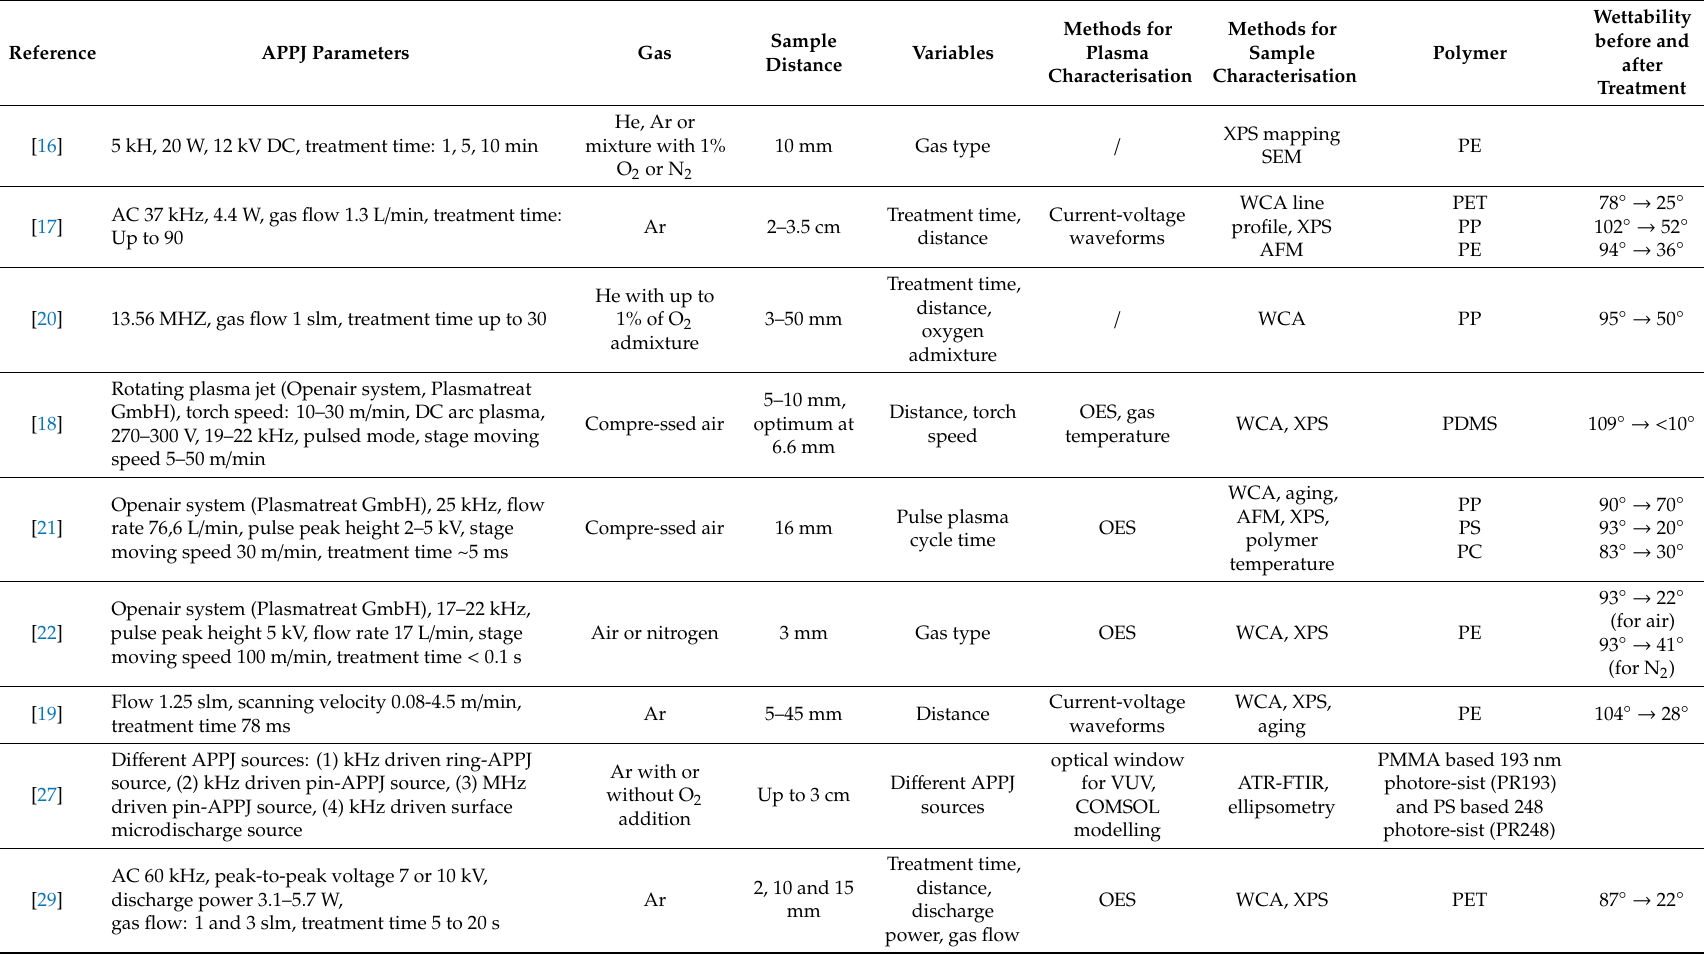
Table 1. Literature overview. APPJ, atmospheric-pressure plasma